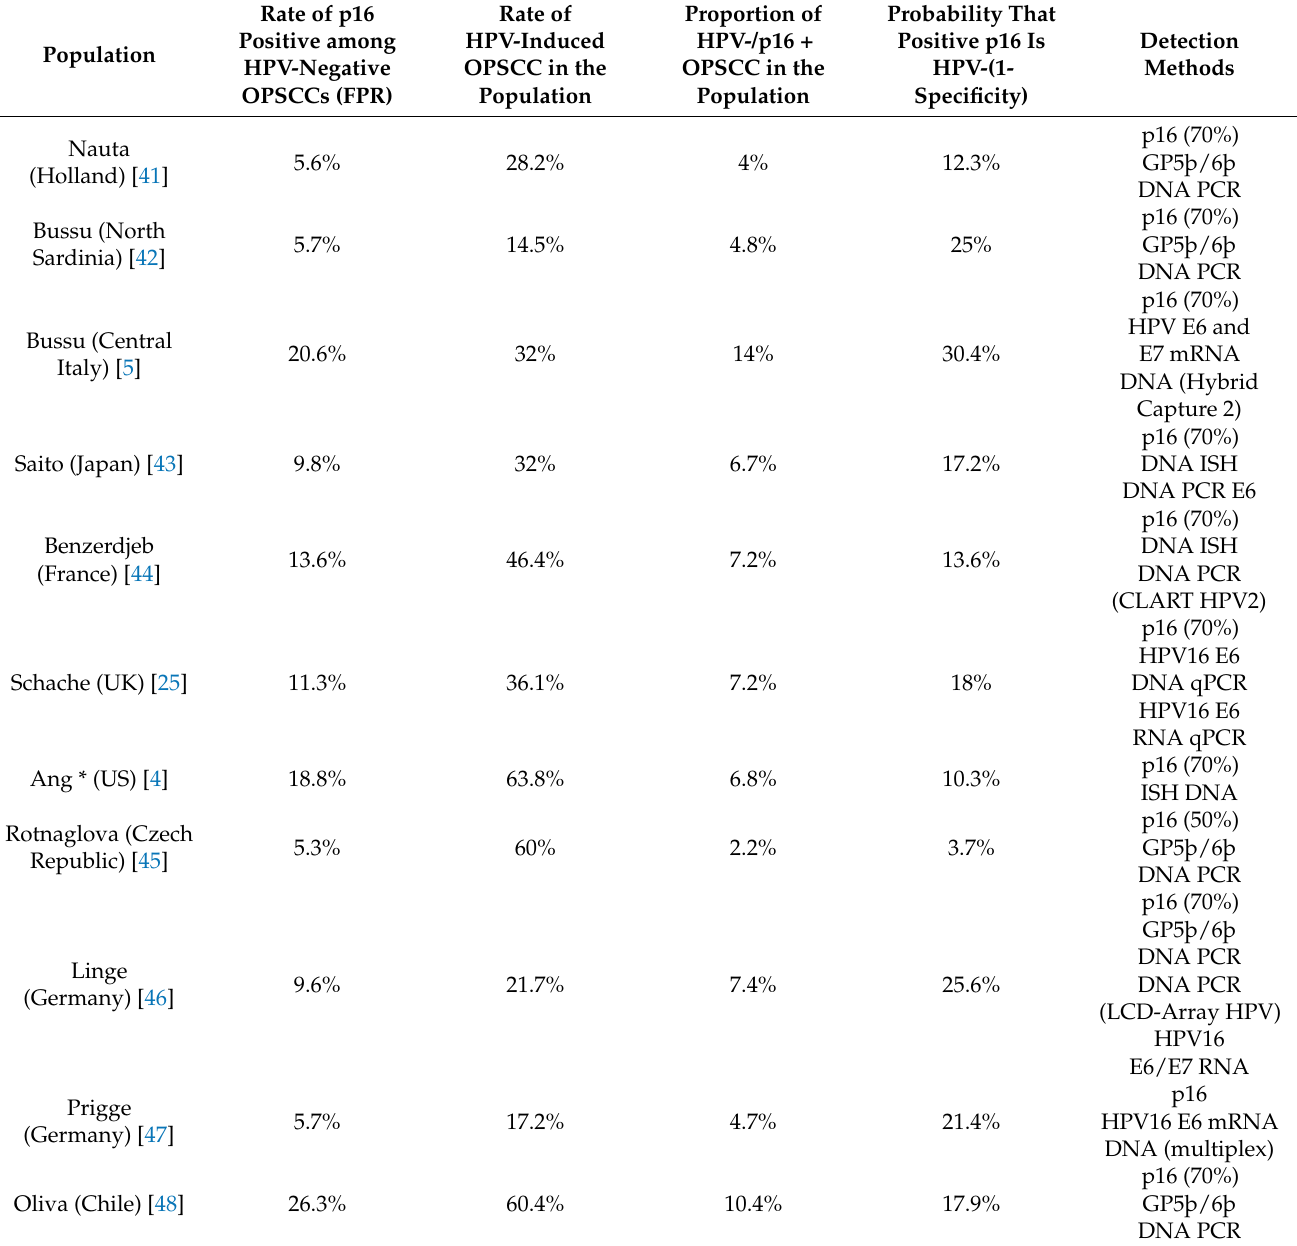
Table 1. Accuracy of p16 IHC in different OPSCC series. Notably, for a certain assay, the FPR is relatively constant among very different populations (such as the Dutch, Germans, Czechs,